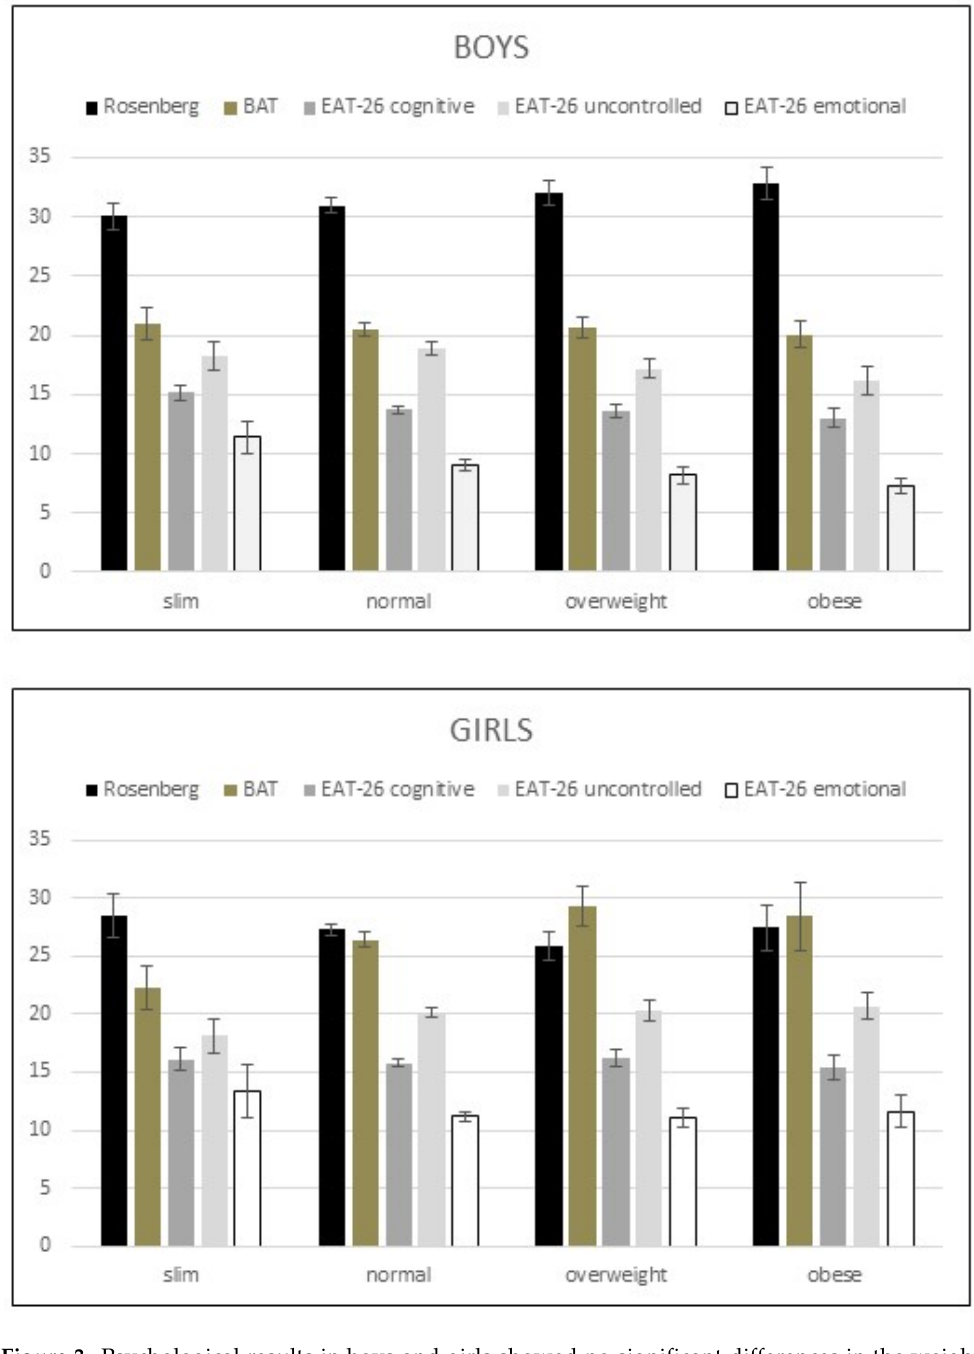
Figure 3. Psychological results in boys and girls showed no significant differences in the weight groups (data are shown as mean ± S.E.M, p < 0.05). (Rosenberg = Rosenberg Self-esteem Scale; BAT = Body Attitude Test; EAT-26 = Eating Attitudes test: cognitive restraint, uncontrolled eating, emotional eating).